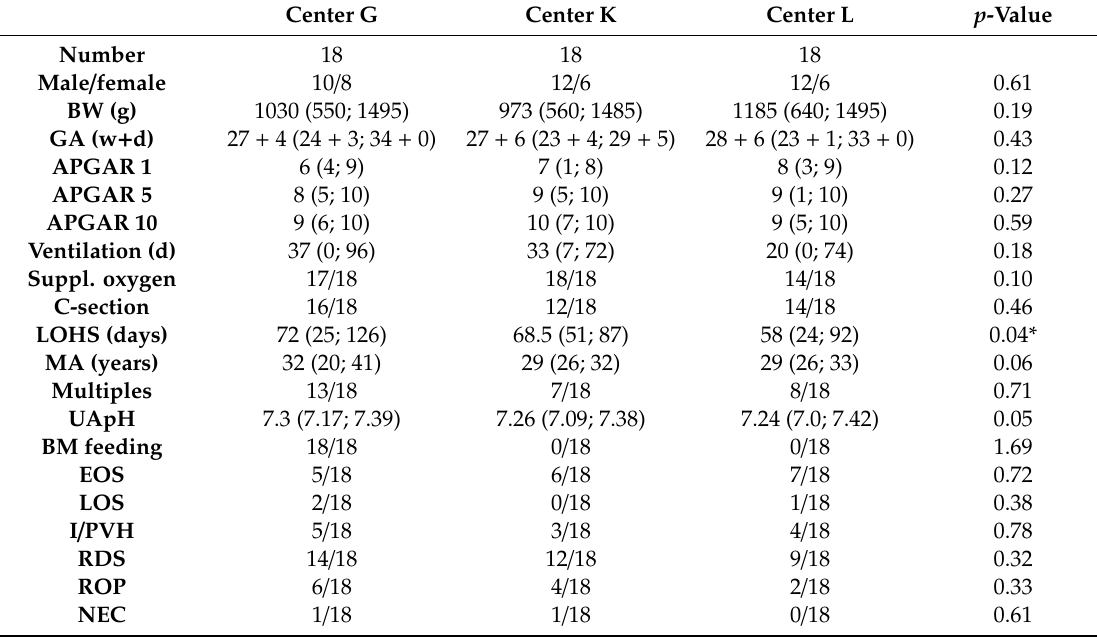
Table 2. Perinatal and neonatal data of the study population. Center G Center